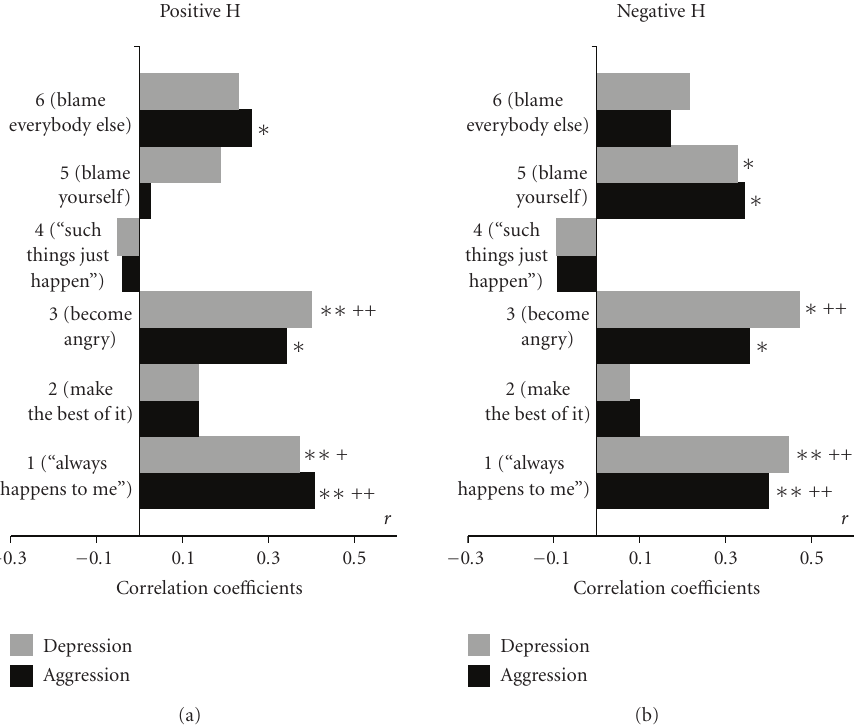
Figure 4: correlations of factors Depression and Aggression with QDF scales for human conditions; withdrawal from positive reinforcers: posH, (a); encounter with negative reinforcers: negH, (b) ( ∗ P < . 05; ∗∗ P < . 01; + P < . 05; ++ P < . 01 after Bonferroni